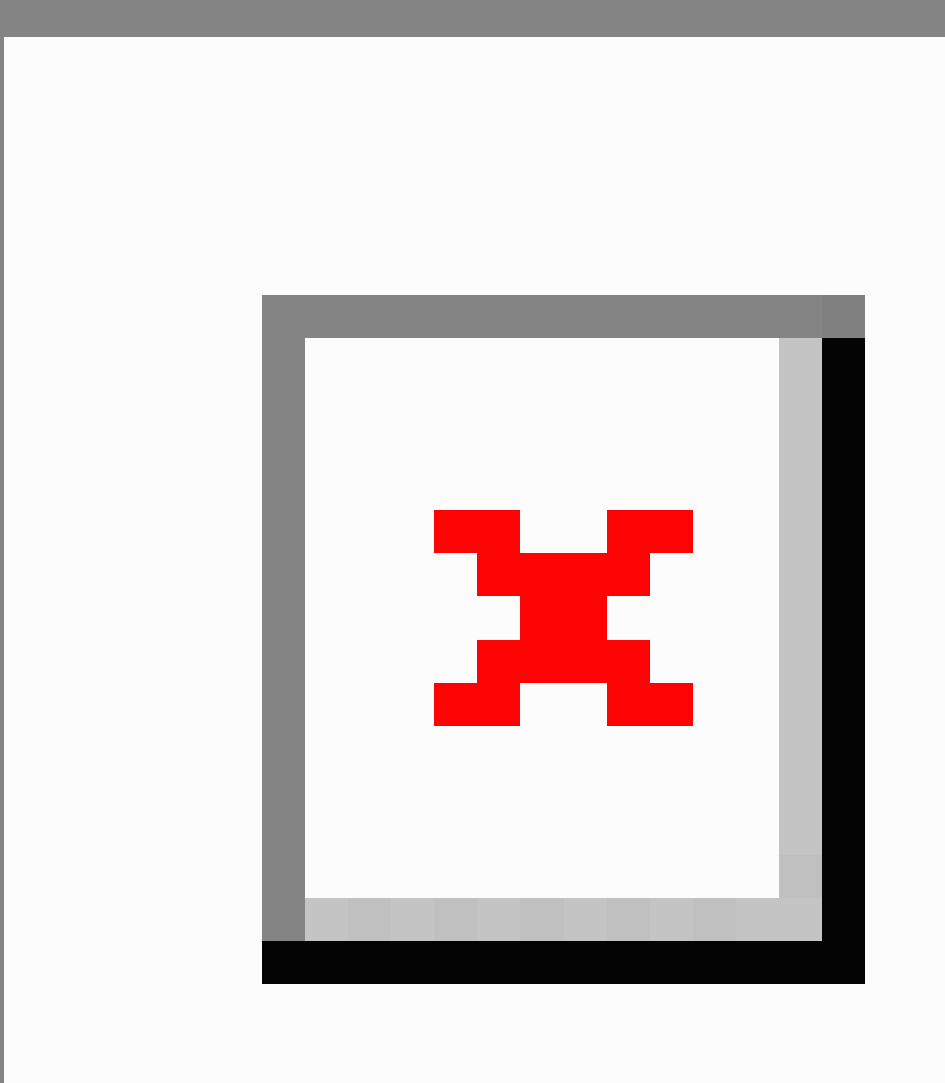
Figure 5. Distribution of correct and partially correct interpretations for the 20